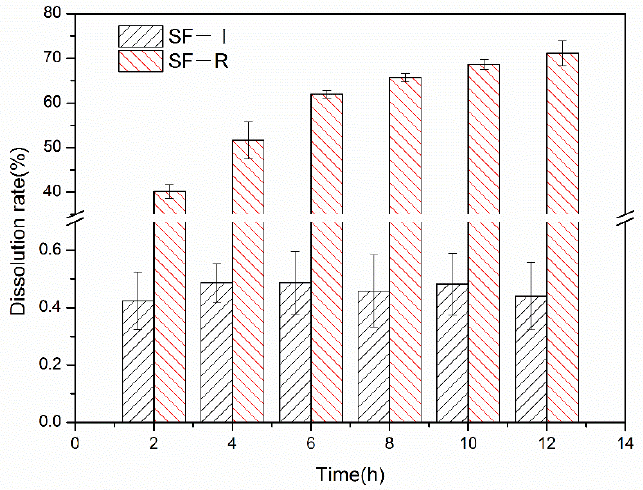
Figure 1. Water loss rate of different silk fibroin materials (SF-I and SF-R) for 2, 4, 6, 8, 10, and 12 h.